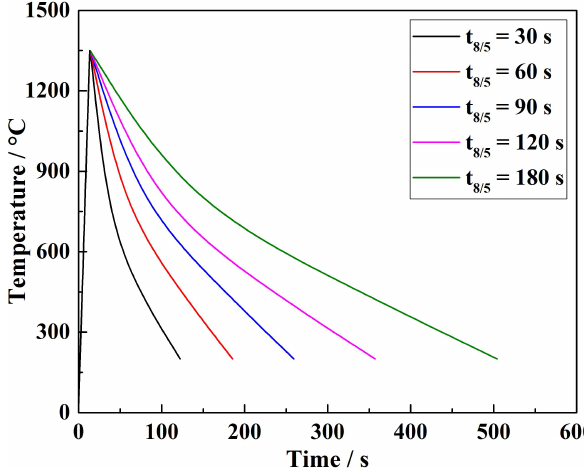
Figure 1: Welding thermal cycles applied in CGHAZ simulation for different heat